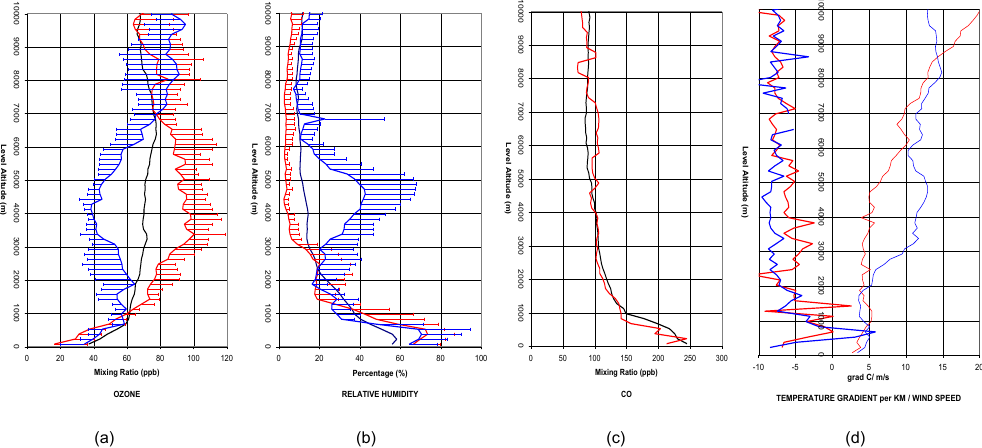
Fig. 10. (a) Vertical profiles of summer (JJA) ozone over the eastern Mediterranean airport of Tel Aviv for the 7% highest (red) and the 7% lowest (blue) ozone mixing ratios at 1500–5000m; (b) same as (a) but for relative humidity; (c) same as (a) but for carbon monoxide (CO); (d) (left), same as (a) but for temperature gradient per km; (right), same as (a) but for wind speed. The black line in (a, b, c) , shows the mean profile of the respective parameter. In (c) no CO data are available during lowest ozone days. There are missing profiles in (c) .